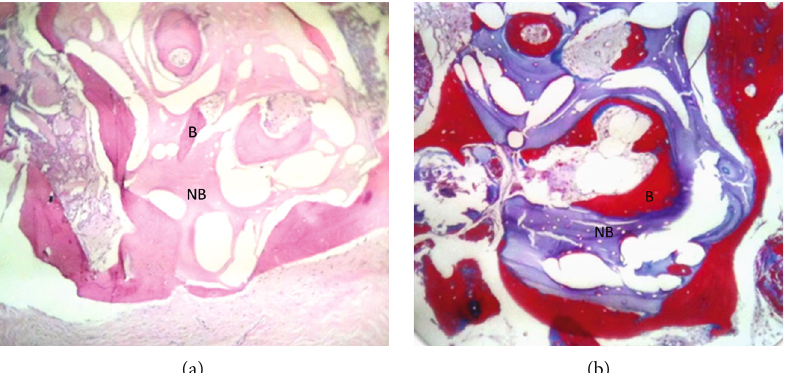
Figure 4: Photomicrograph showing newly formed bone in the grafted area at 6 months. (a) Hematoxylin and eosin stain (100 × ). (b) Masson ’ s trichrome stain (100 × ). Newly formed bone was observed in intimate contact with remaining particles of biomaterial (b), and many osteocytes were distributed in the newly formed bone and, in some areas, were totally integrated, demonstrating biocompatible